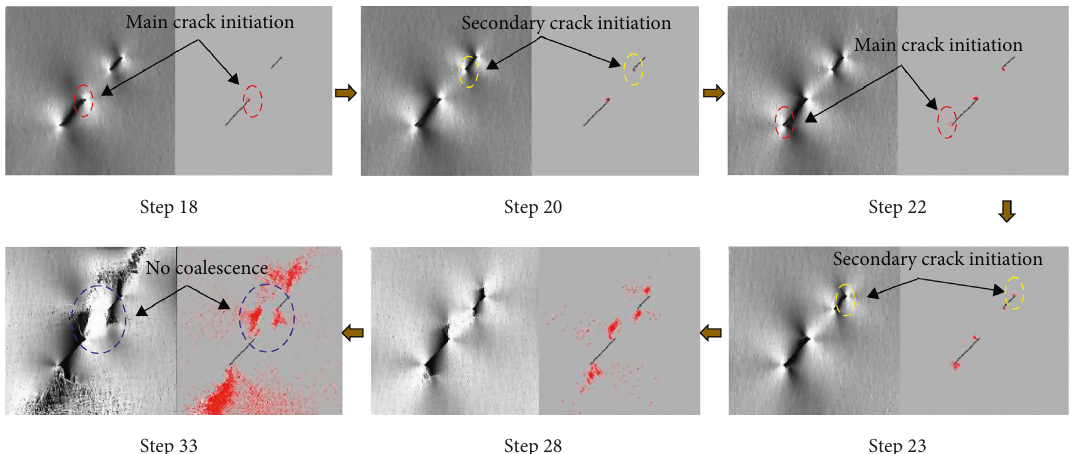
Figure 24: Crack initiation and propagation process in Model 4.